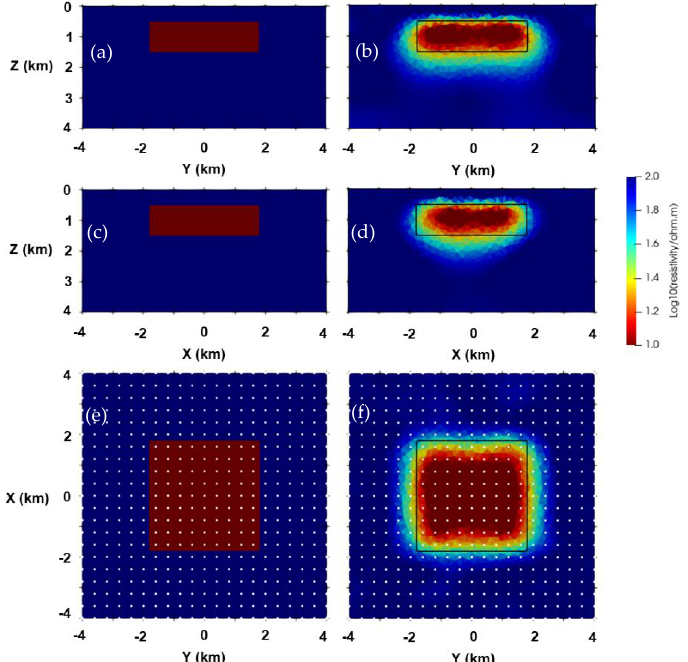
Figure 5. The inverted principal conductivity along the X-axis. Panels ( a ) and ( b ) show the true model and the recovered model at x = 0 km. Panels ( c ) and ( d ) show the true model and recovered model at y = 0 km. Panels ( e ) and ( f ) show the true model and the recovered model at z = 1 km.